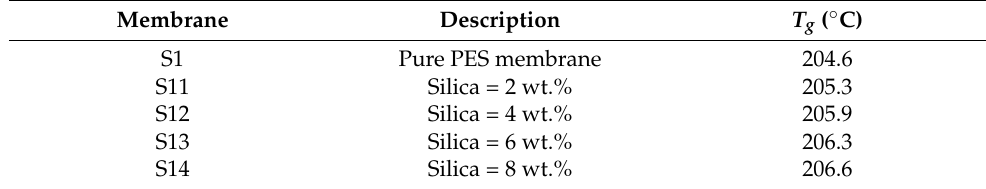
Table 2. T g of pure PES membrane and PES/modified silica MMMs at various silica loadings.